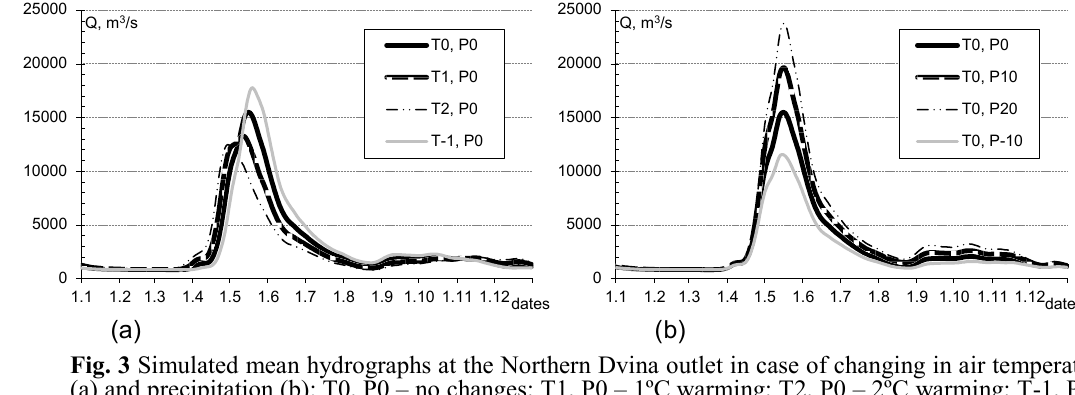
Fig. 3 Simulated mean hydrographs at the Northern Dvina outlet in case of changing in air temperature (a) and precipitation (b): T0, P0 – no changes; T1, P0 – 1ºC warming; T2, P0 – 2ºC warming; T-1, P0 – 1ºC decrease of air temperature, T0, P10 – 10% increase of precipitation; T0, P20 – 20% increase of precipitation; T0, P-10 – 10% decrease of